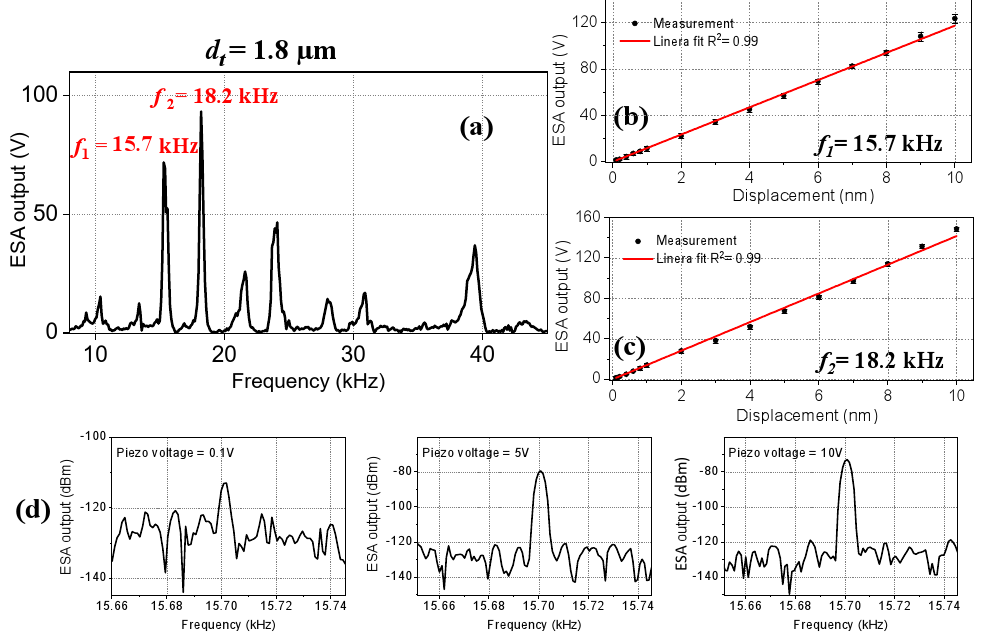
Figure 5. ( a ) The frequency spectrum of the tapered-tip fiber microcantilever with a tip diameter of d t = 1.8 µm. Several natural resonance frequencies were observed. The ESA output versus displacement values for the first two resonance frequencies of ( b ) f 1 = 15.7 kHz and ( c ) f 2 = 18.2 kHz. The red line indicates the linear fit. ( d ) The ESA output spectrum at different V = 0.1 V, 5 V, and 10 V for f 1 = 15.7 kHz.